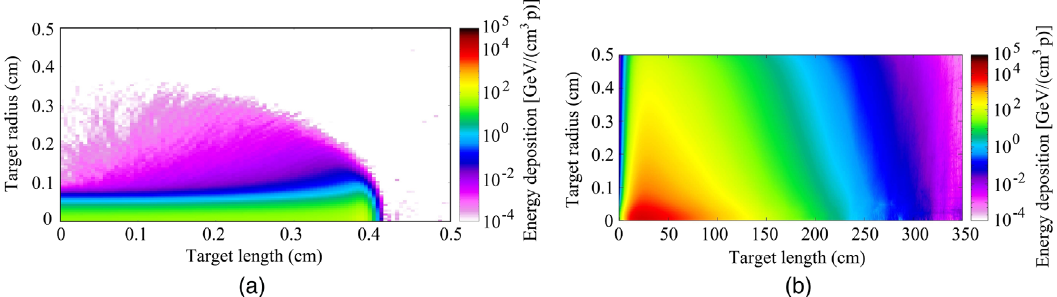
mm.FIG. 2. Two-dimensional energy deposition in the units of GeV = cm 3 per proton in a solid copper target at the energies of (a) 50 MeV and (b) 50 TeV. The rms beam size is σ ¼ 0 . 2